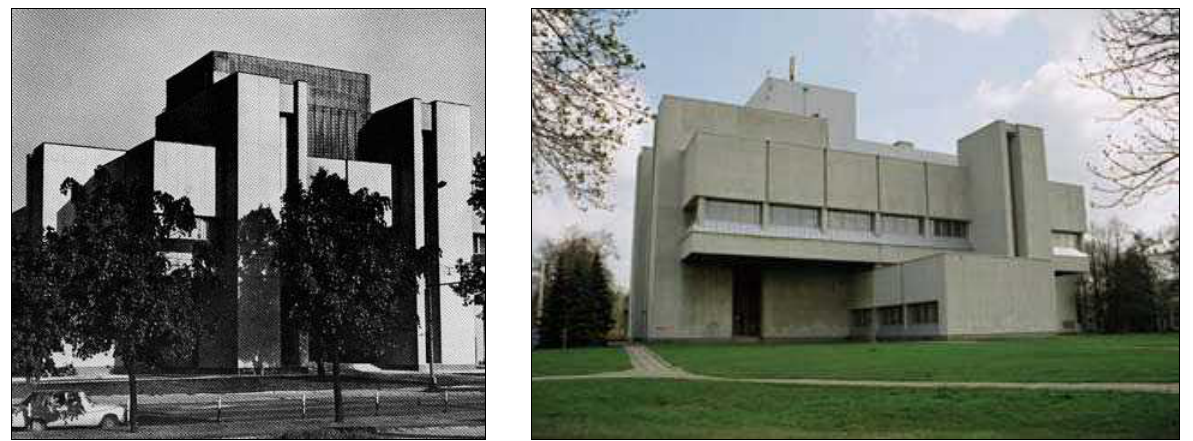
Figs. 1, 2. Sports and entertainment Palace in Vilniu­s (arch. a­. Mačiu­lis) in 1983 and